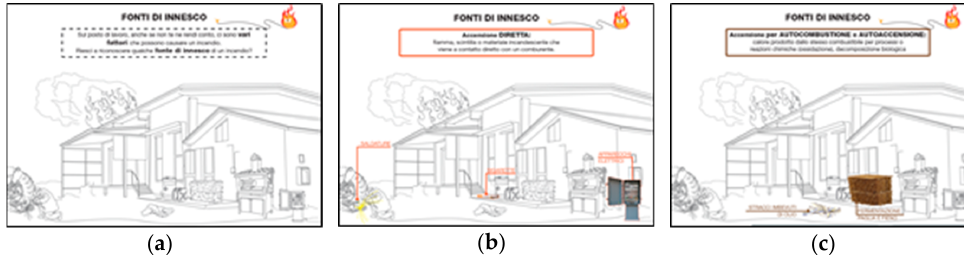
Figure 3. Quiz slide to encourage the involvement of participants in regard to fire risk: ( a ) participants were asked whether they recognised some ignition sources; ( b ) direct ignition source was highlighted; and ( c ) spontaneous ignition source was highlighted.